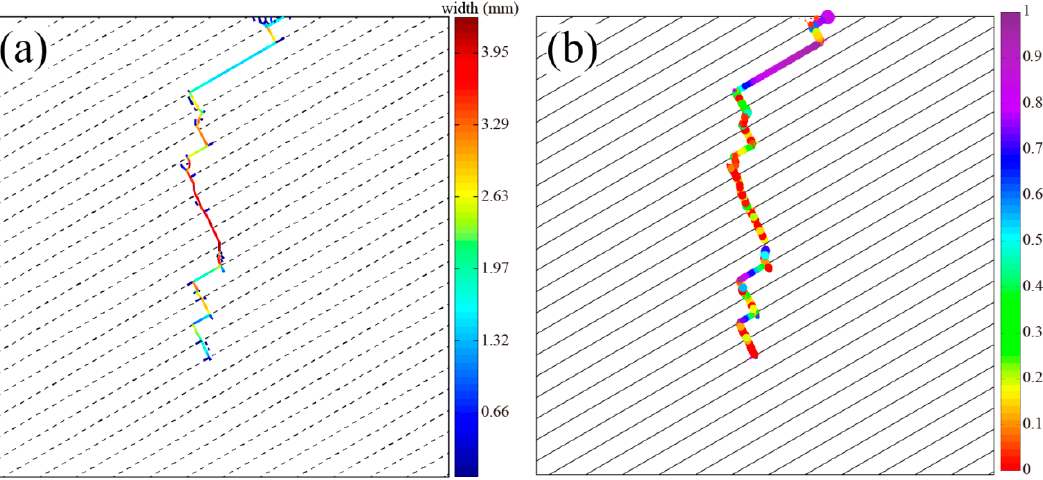
Figure 11. Fracture closure degree and AE location. In figure ( a ), different colors represent the fracture widths, which increased from blue to red. In figure ( b ), the fracture type is represented by color. Red points represent pure tensile fractures and purple points represent pure shear fractures.